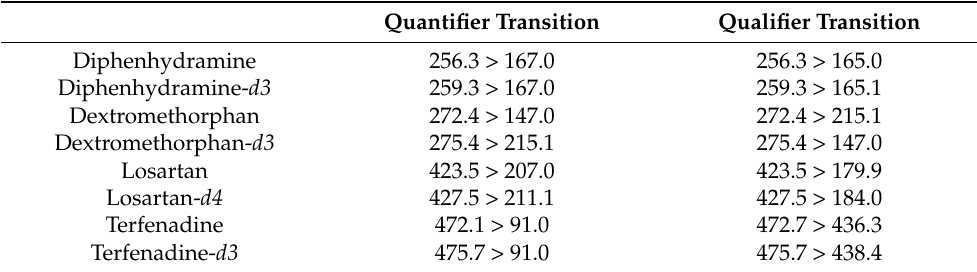
Table 2. MRM transitions for the drugs and respective internal standards. The peak area of the quantifier trace was used for the quantification whilst the qualifier trace was used to verify the identity of the integrated